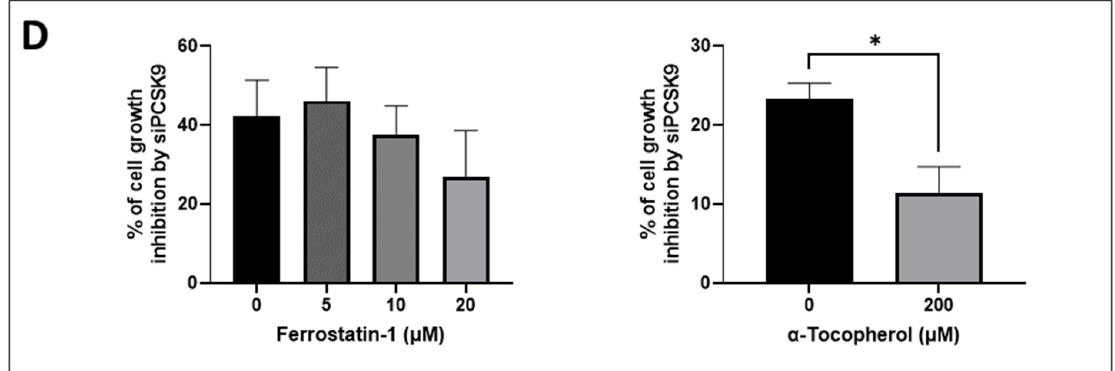
Figure 5. Morphological and molecular features of ferroptosis with PCSK9 deficiency. ( A ) The central regulator that inhibits ferroptosis is the selenoprotein GPX4, which together with reduced glutathione (GSH), has an antioxidant capacity against lipid reactive oxygen species (ROS), thus blocking ferroptosis (right side). The pathways that lead to the activation and synthesis of GPX4/GSH and hence ferroptosis inhibition include the System Xc - -mediated import of cysteine (Cys), production of cysteine by the transsulfuration (TS) pathway and finally, the production of selenocysteine (Se) by the mevalonate pathway. Another important product of the mevalonate pathway is the CoQ10, which can inhibit ferroptosis independently of GPX4. The oxidoreductase FSP1 reduces CoQ10 to ubiquinol (CoQ10 H 2 ) which can trap lipid ROS and then regenerates CoQ10 using NAD(P)H. (left side) The p62/Keap1/Nrf2 pathway plays an important role in inhibiting ferroptosis by activating the expression of antioxidant defense genes NAD(P)H quinone dehydrogenase 1 (NQO-1), FTH-1 and heme oxygenase 1 (HO-1). Under normal conditions, Keap1 binding to Nrf2 induces its ubiquitination and hence proteasome degradation. Under stress conditions, p62 binds to Keap1, the inhibitor of Nrf2, thus stabilizing Nrf2 which can then translocate to the nucleus and induce the expression of antioxidant defense genes. On the other hand, the pathways that lead to lipid ROS accumulation and induction of ferroptosis include: the accumulation of free intracellular ferrous (Fe2 + ) that can produce hydroxyl and peroxide radicals by the Fenton reaction, hence oxidizing lipids, and idation by increasing ALOX-15 levels; this leads to the production of PUFAs, which are sensitive to lipid peroxidation, resulting in ferroptosis. Abbreviations: ACAC: Acetyl-CoA carboxylase; ACSL4: